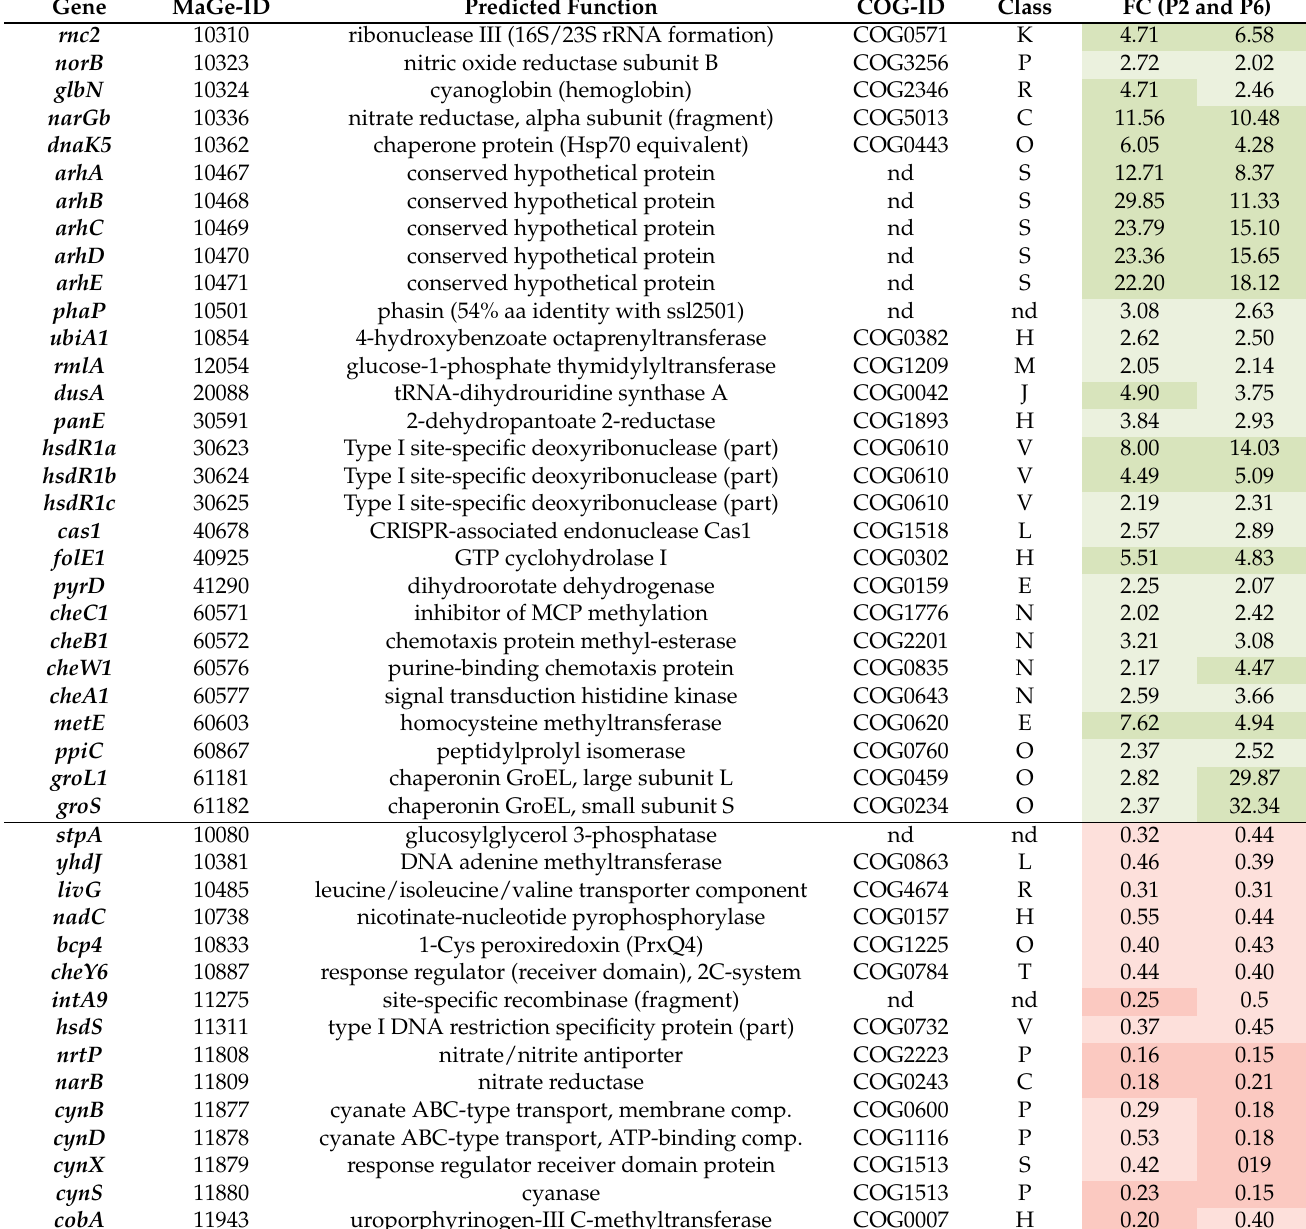
Table 5. Irradiation-induced and repressed genes of known function common to P2 and